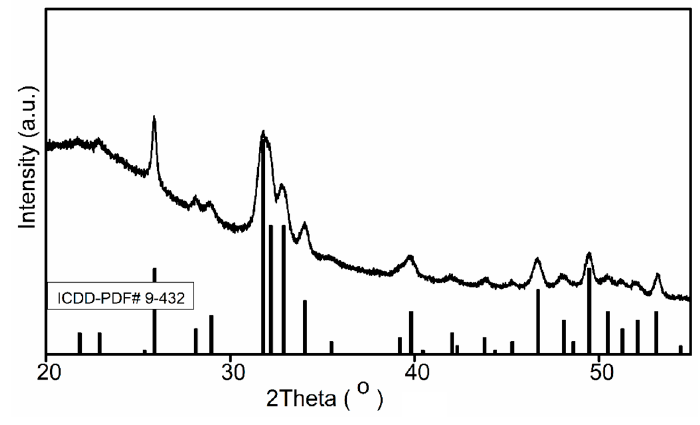
Figure 1. XRD pattern of HAp powder.